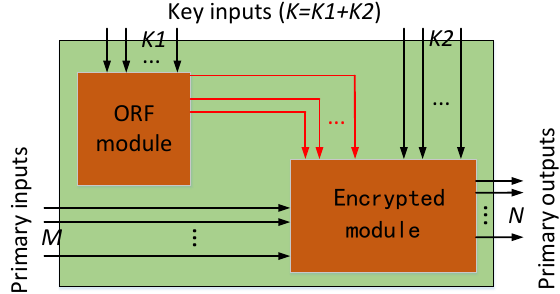
Figure 2. one-way random functions (ORF) based countermeasure against SAT (satisfiability checking)